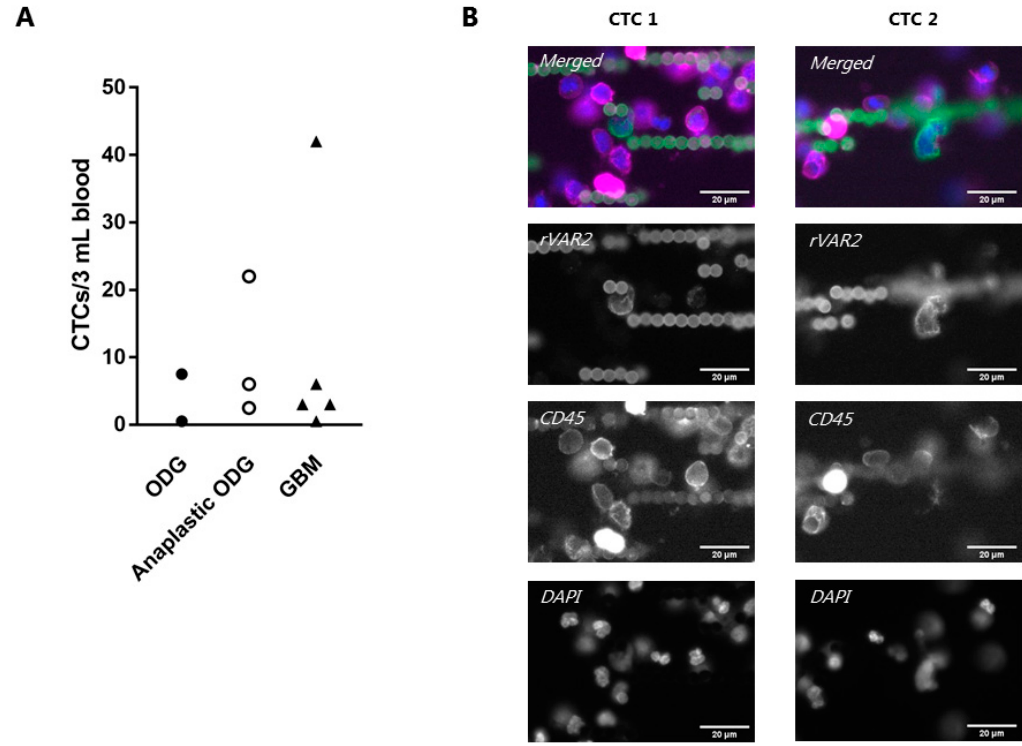
Figure 5. rVAR2 enables capture and detection of glioma circulating tumor cells (CTCs) from patient blood samples. ( A ) Average CTC count in blood samples from ten glioma patients. 3 mL blood samples were processed by using rVAR2-coupled beads followed by staining using a mixture of fluorophore-conjugated rVAR2 (green), anti-CD45/CD66b antibodies (red) and DAPI (blue). CTCs were defined as rVAR2+, CD45/CD66b − , DAPI+ cells. Each dot represents the average number of detected CTCs per 3 mL patient blood sample. The x-axis shows whether the patient was diagnosed with GBM, Anaplastic Oligodendroglioma (ODG), or Oligodendroglioma (ODG). ( B ) Representative images of identified CTCs from a patient diagnosed with GBM. The sample was stained with flurophore-conjugated rVAR2 (green), anti-CD45 antibody (magenta), and DAPI (blue). Images were obtained using the CellCelector™ (ALS) with a 40× objective. Scale bars, 20 µm.